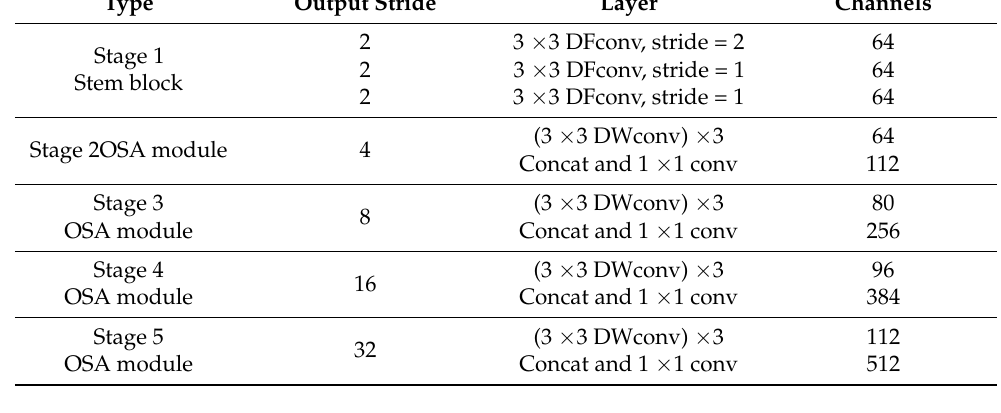
Figure 2. Structure of the OSA module.